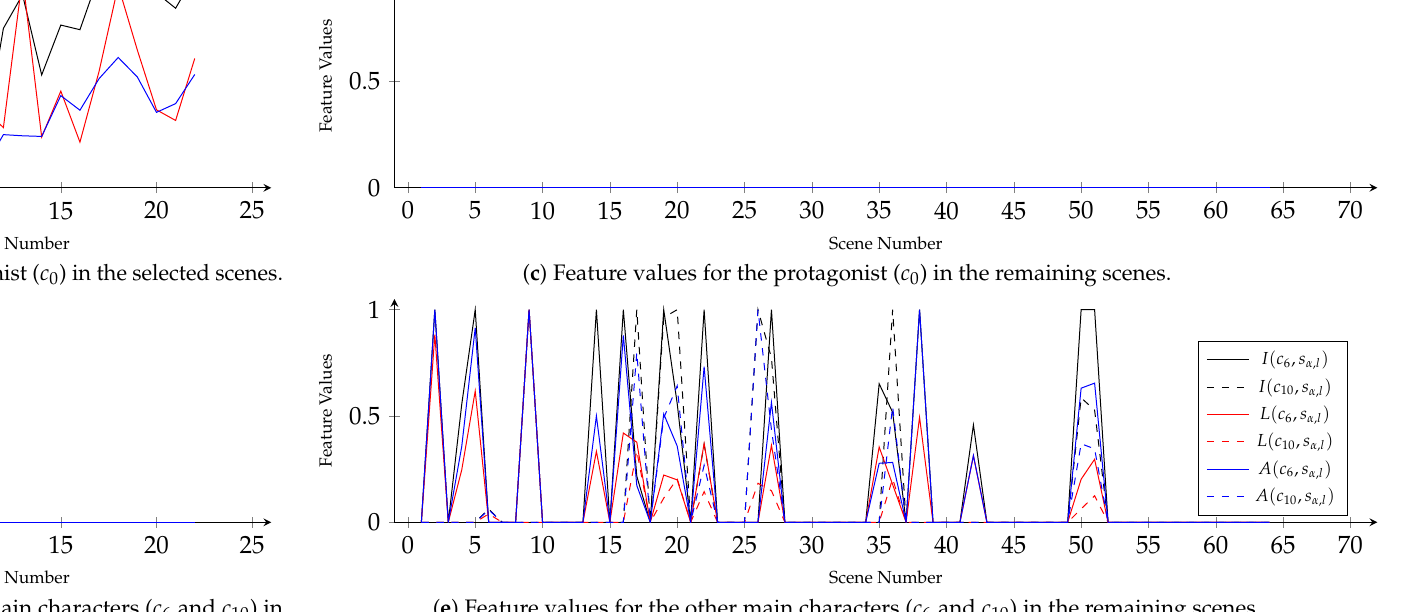
( e ) Feature values for the other main characters ( c 6 and c 10 ) in the remaining scenes. ( d ) Feature values for the other main characters ( c 6 and c 10 ) in the selected scenes. Figure 5. A story line discovered by the second iteration of the proposed decomposition method from ‘Good Will Hunting’ (1997). ( a ) presents feature values for ‘Chuckie’ on scenes excluding the first story line. ( b , c ) present changes in the feature values for ‘Chuckie’ in the selected and remaining scenes, respectively. ( d , e ) illustrate feature values for ‘Sean’ and ‘Lambeau’ in the selected and remaining scenes,